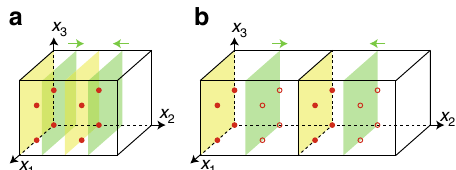
Fig. 2 Layer constructions for space group P (cid:1) 1 (#2). a The yellow planes are ) respectively, and the two green planes are (010; d ) (010; 0) and (010; 1 2 and (010; 1 − d ) with d ≠ 0, 1 . The arrows mean that the two green planes 2 can move towards each other without breaking inversion. b After doubling the unit cell along x 2 -direction, the open dots are no longer inversion centers as they were, whereas the solid dots remain. Again the arrows mean that two green planes can move towards each other without breaking the inversion symmetry, after unit